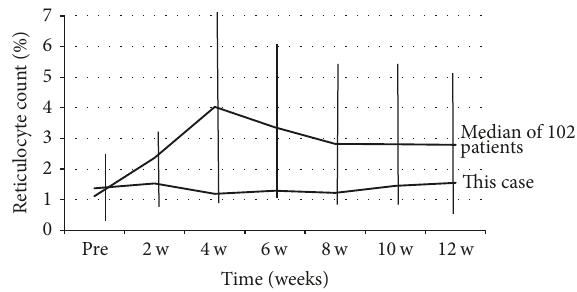
Figure 4: The variation of reticulocyte count during treatment with IFN and RBV combination therapy in this case and median of another 102 patients treated by our hospital.